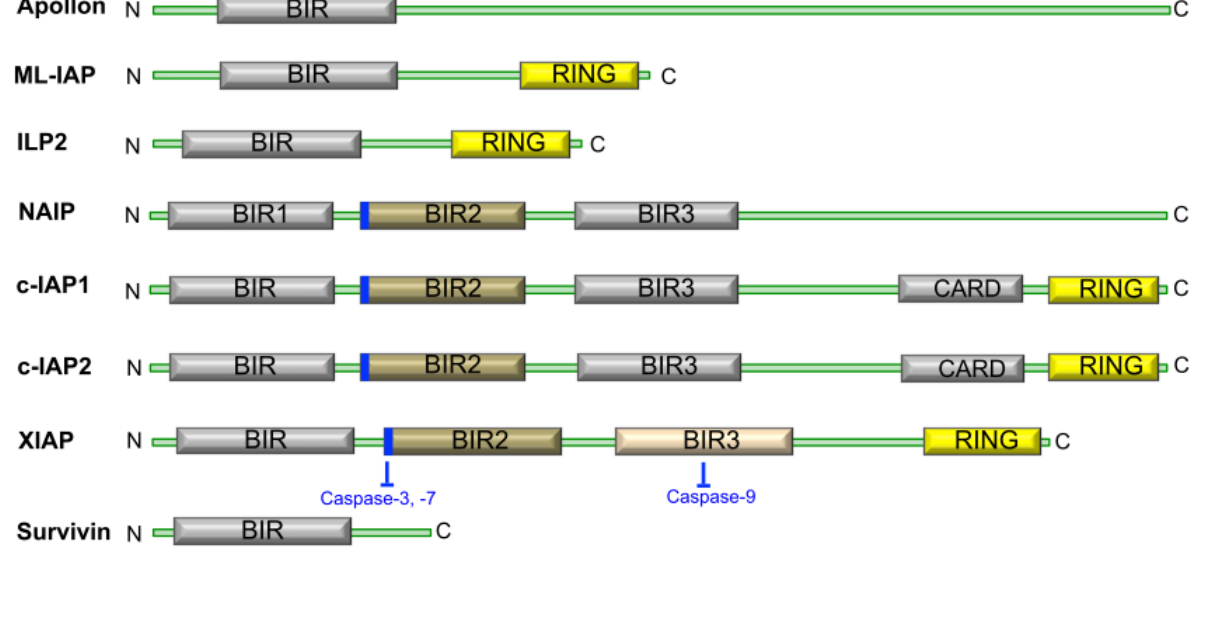
Figure 1. Inhibitor of Apoptosis Protein (IAP) structure in mammals. The IAP family of proteins consists of eight proteins including Apollon, ML-IAP (melanoma